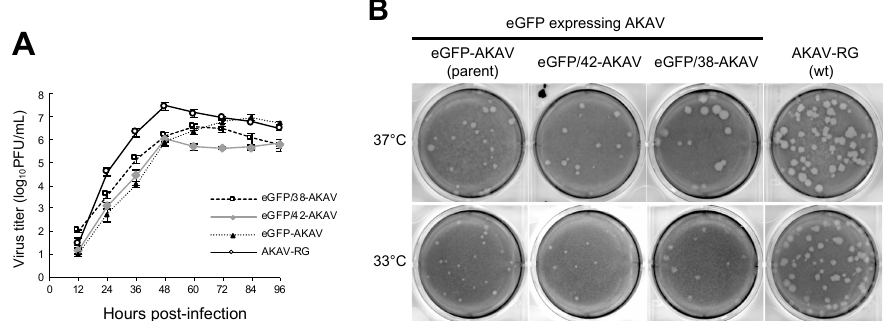
Figure 2. Growth kinetics and plaque morphology of recombinant viruses. ( A ) To assess the growth curves for recombinant viruses, HmLu-1 cells were infected with parent eGFP-AKAV, deletion viruses (eGFP / 42- and eGFP / 38-AKAVs), or wt AKAV-RG at a multiplicity of infection (MOI) of 0.01. The viral titers were determined using a plaque assay. The results are presented as the mean ± SD (error bars) from three independent experiments. ( B ) The plaque phenotypes of eGFP-, eGFP / 42-, eGFP / 38-AKAVs, and wt AKAV-RG viruses at 37 ◦ C and 33 ◦ C are shown.